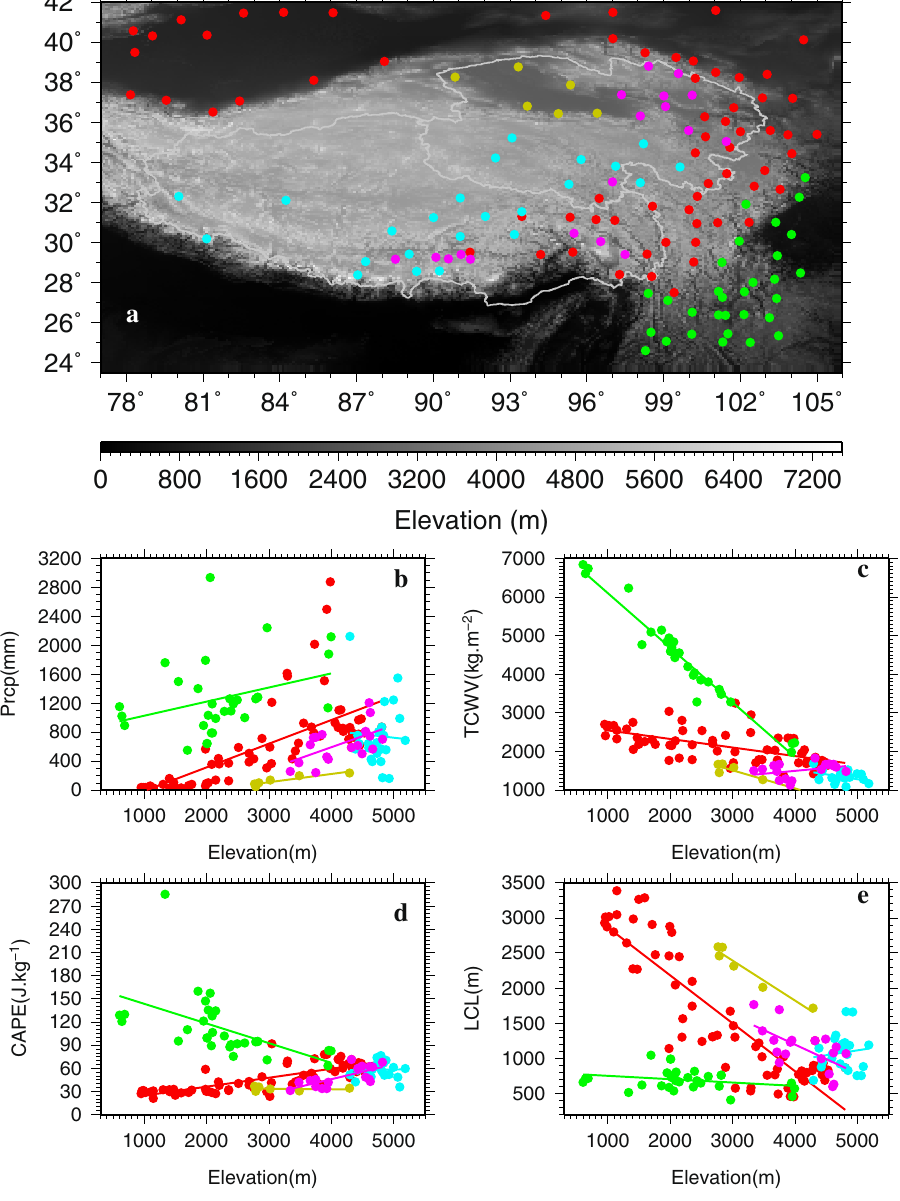
Figure 5. Locations of the MERRA2 cells whose wet season precipitation is correlated statistically significantly at 90% confidence level with that of the corresponding stations ( a ). Vertical distributions of wet season precipitation ( b ), total column water vapor (TCWV) ( c ), convective available potential energy (CAPE) ( d ), and lifting condensation level (LCL) ( e ) with MERRA2 elevation for the MERRA2 cells that are separated into the same color-coded 5 groups as for the observations. This figure was plotted using the Generic Mapping Tools (GMT) V4.5.0